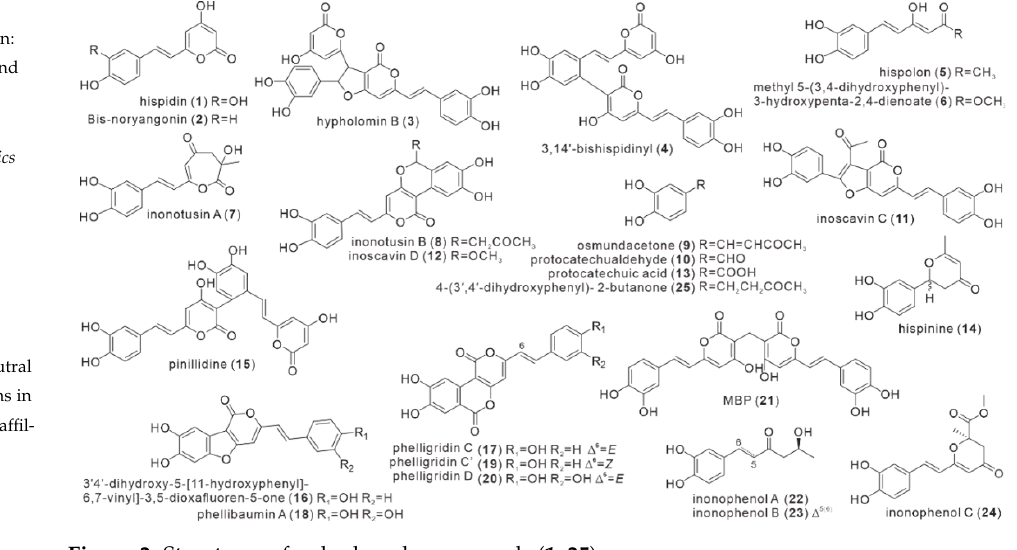
Figure 2. Structures of polyphenol compounds ( 1 – 25 ).